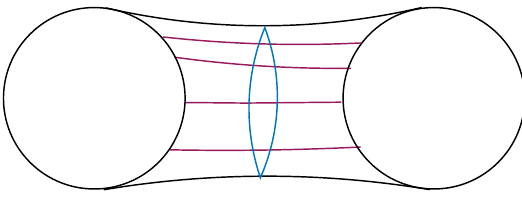
Figure 5 . Upon purifying the threads can naturally be seen as extending from one side of the wormhole to the other saturating on the minimal wormhole